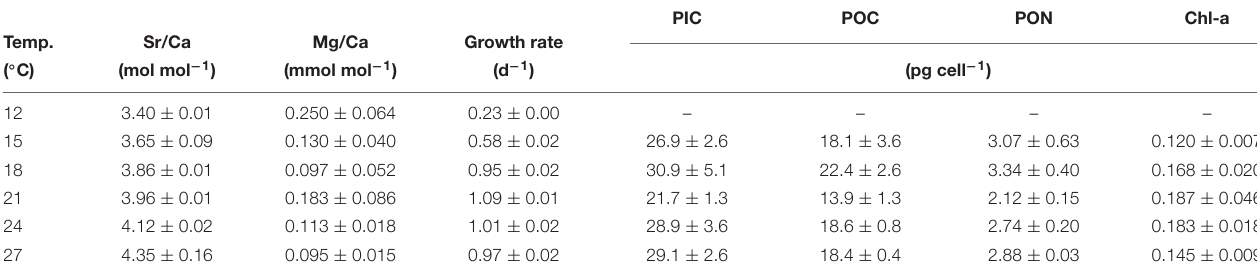
PIC POC PON Chl-a